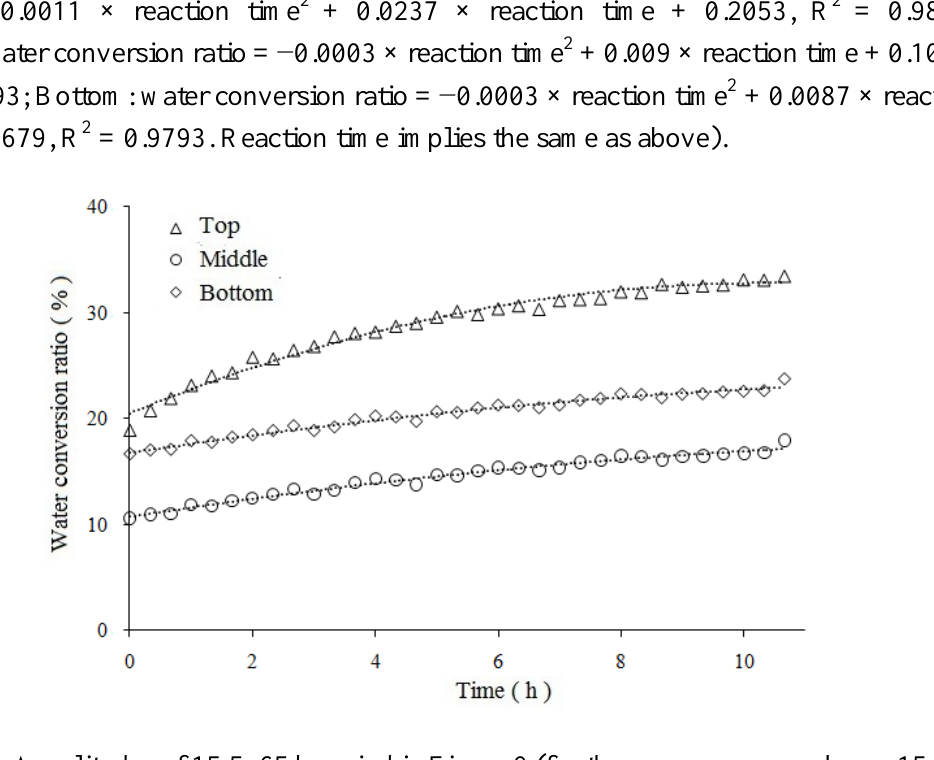
Figure 12. Amplitudes of 15.5–65 h period in Figure 9 (for the same reason as above, 15.5 h, 65 h in Figure 8 were respectively translated into 0 h, 50 h. Top: water conversion ratio = −0.00003 × reaction time 2 + 0.0052 × reaction time + 0.3395, R 2 = 0.9954; Middle: water conversion ratio = −0.00003 × reaction time 2 + 0.0032 × reaction time + 0.18, R 2 = 0.9795; Bottom: water conversion ratio = −0.00003 × reaction time 2 + 0.0031× reaction time + 0.238, R 2 = 0.9795. Reaction time implies the same as